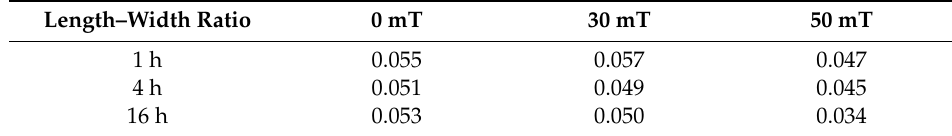
Table 7. The influence of the electromagnetic field within the length–width ratio of δ phase for di ff erent aging